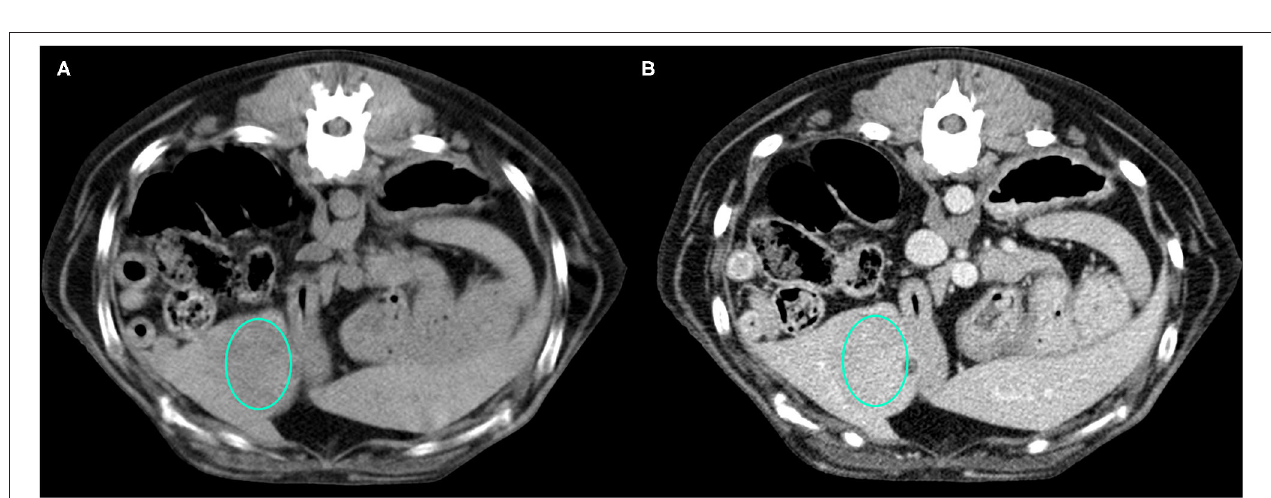
FIGURE 1 | Example of a NH lesion that shows hypoattenuation and hypoenhancement, diffuse contrast enhancement pattern, with heterogeneous distribution, well-defined margins, irregular surface, and cyst-like appearance. (A) image obtained from the pre-contrast scan; (B) image obtained from the delayed scan. A ROI is placed inside the lesion in both. Based on the developed decision tree this lesion was classified as OBL.